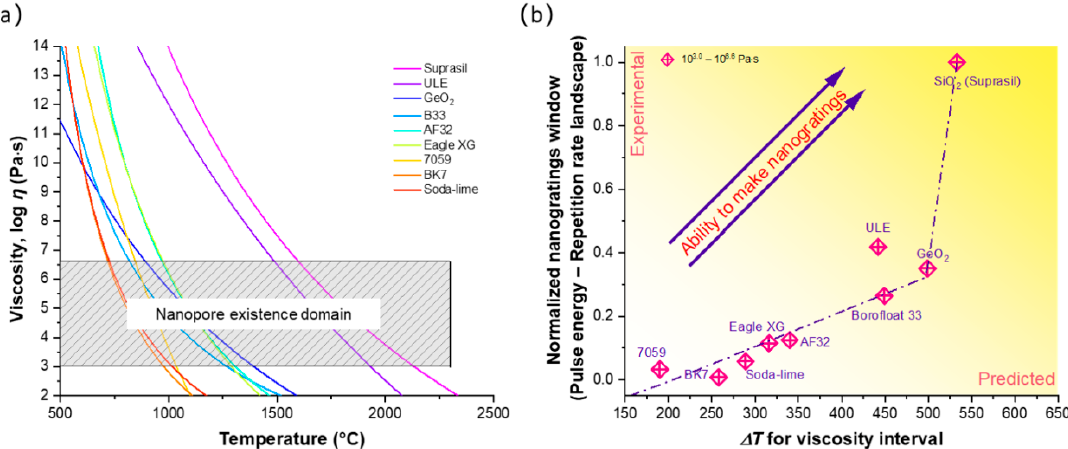
Figure 6. ( a ) Viscosity as a function of temperature for a variety of commercial and typical glasses, along with an estimated domain of NG existence from T soft ( η = 10 6.6 Pa · s) to T max ( η = 10 3.0 Pa · s). ( b ) Normalized NG window as a function of the temperature interval ( ∆ T ) corresponding to the previously mentioned viscosity interval.